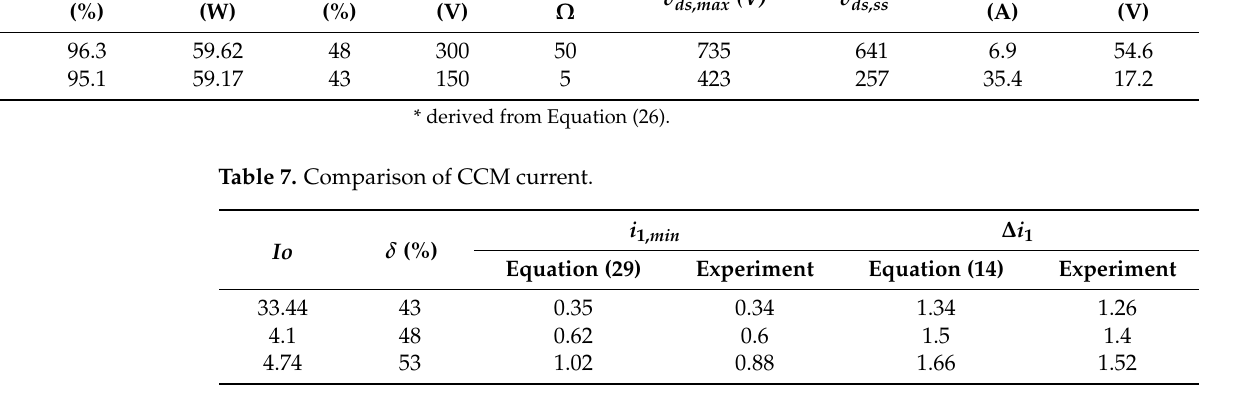
Figure 19. Photo of the circuit in the experiment. 5. Discussion The conventional cascode GaN HEMT, namely Type 1A, usually requires to co-work with a low voltage LDMOS in order to avoid a large portion of the drain – source voltage falling on the MOSFET during its turn-off time and permanently damaging the GaN HEMT on the gate structure. Type 1A with compensation capacitor 𝐶 𝑠 placed side-by- side with the low cost MOS (Type 1B), in this study we adopted IRF610, which can reduce the drain – source voltage during the turn-off time. As shown in Figure 12a, the v ds is stabi- lized to a low voltage without any voltage surge due to the reverse recovery current. The drawback of Type 1B is the extra compensation capacitor 𝐶 𝑠 added to the drain – source side of the NMOS, which will increase the capacitive load when switching the D-mode GaN HEMT off. The power conversion performance is then downgraded in the high volt- age applications as shown in Figure 14a. It is also observed from comparing the wave- forms to the different cascode GaN HEMT; Type 1B presents larger oscillation in GHz high frequency as shown in Figure 12a.